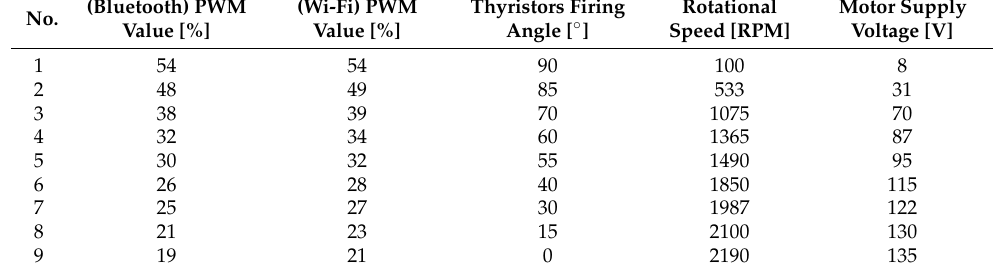
Table 3. Measurements for both control systems with wireless communication.